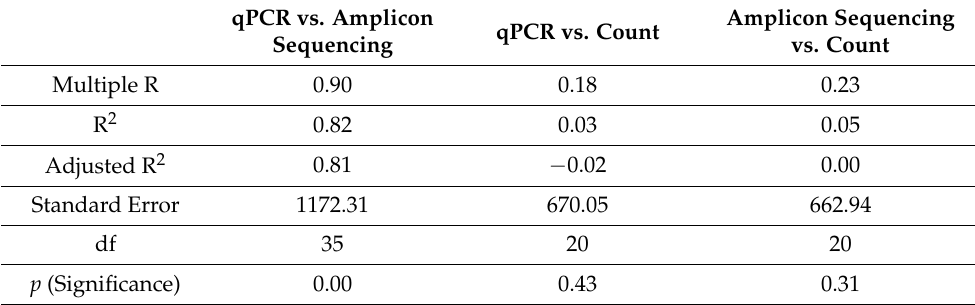
Table 6. Linear regression between qPCR, metabarcoding, and light microscopy.